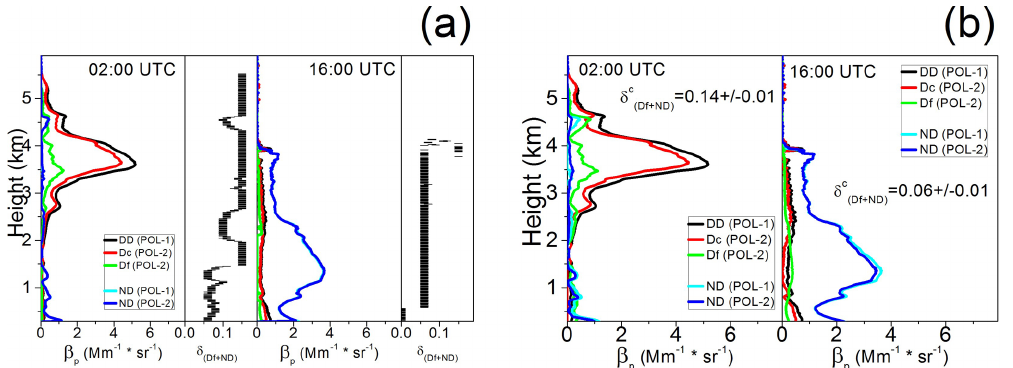
Figure 2. POL-1 versus POL-2 differences in particle backscatter coefficient profiles for each component (total dust β DD and non-dust β ND from POL-1; coarse β Dc and fine β Df dust, being β Dc + β Df = β DD , and non-dust β ND from POL-2) retrieved for the dust case on 5 July 2016 at 02:00 and 16:00UTC by using (optimally derived) (a) a δ Df + ND (z) profile and (b) a single columnar δ c